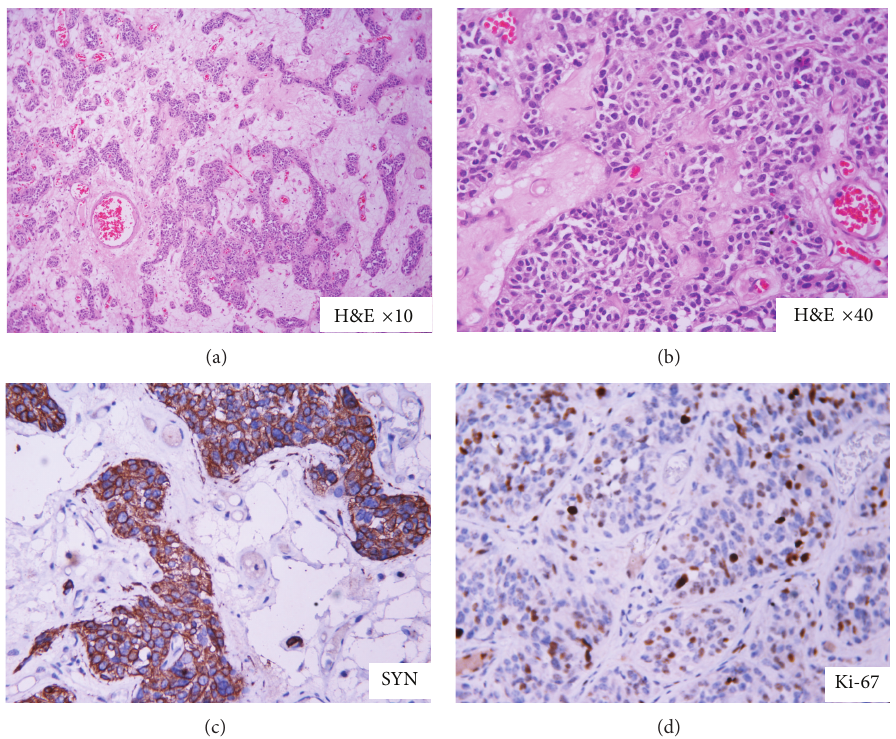
Figure 3: Histopathology of the ablated tumor showing features of carcinoid. Tumor cells are arranged in nests with rich vascular stroma (a). They show salt and pepper type of nuclear chromatin (b). Immunohistochemistry shows positivity for synaptophysin (c) with increased proliferating (KI 67 labelling) index